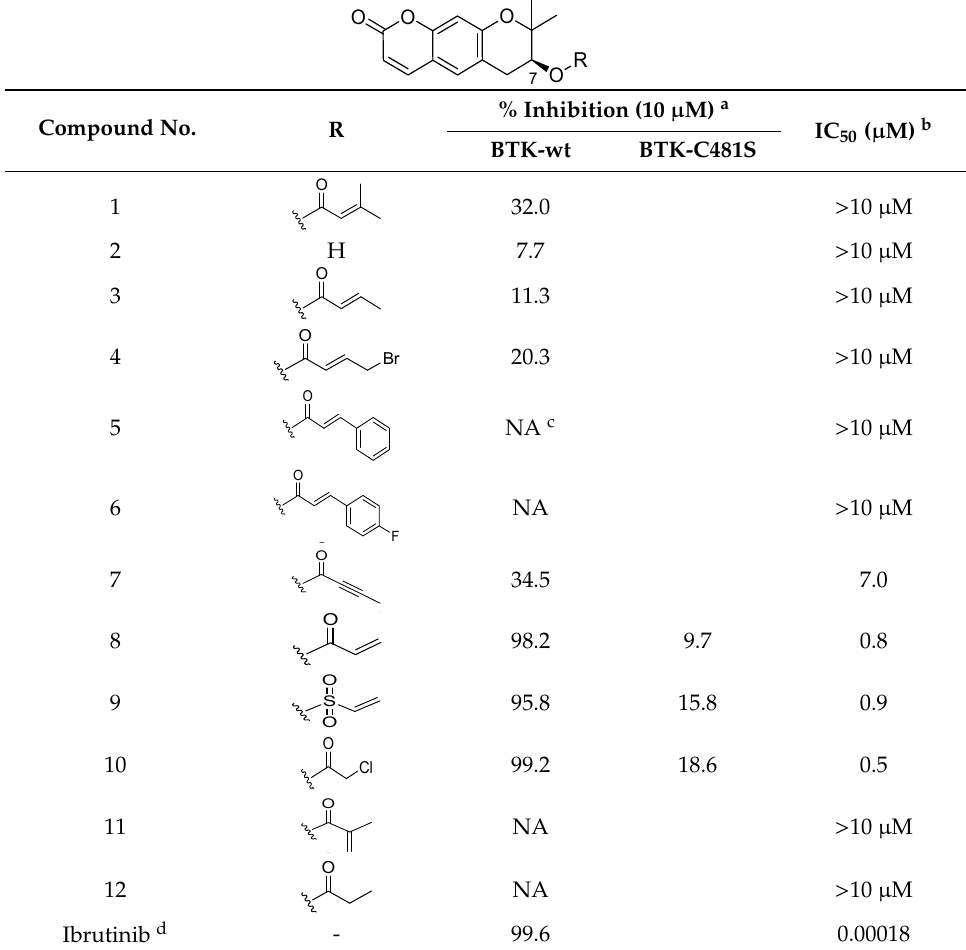
Table 1. Effect of R substituents on BTK inhibition. O O OO R 7 Compound No.